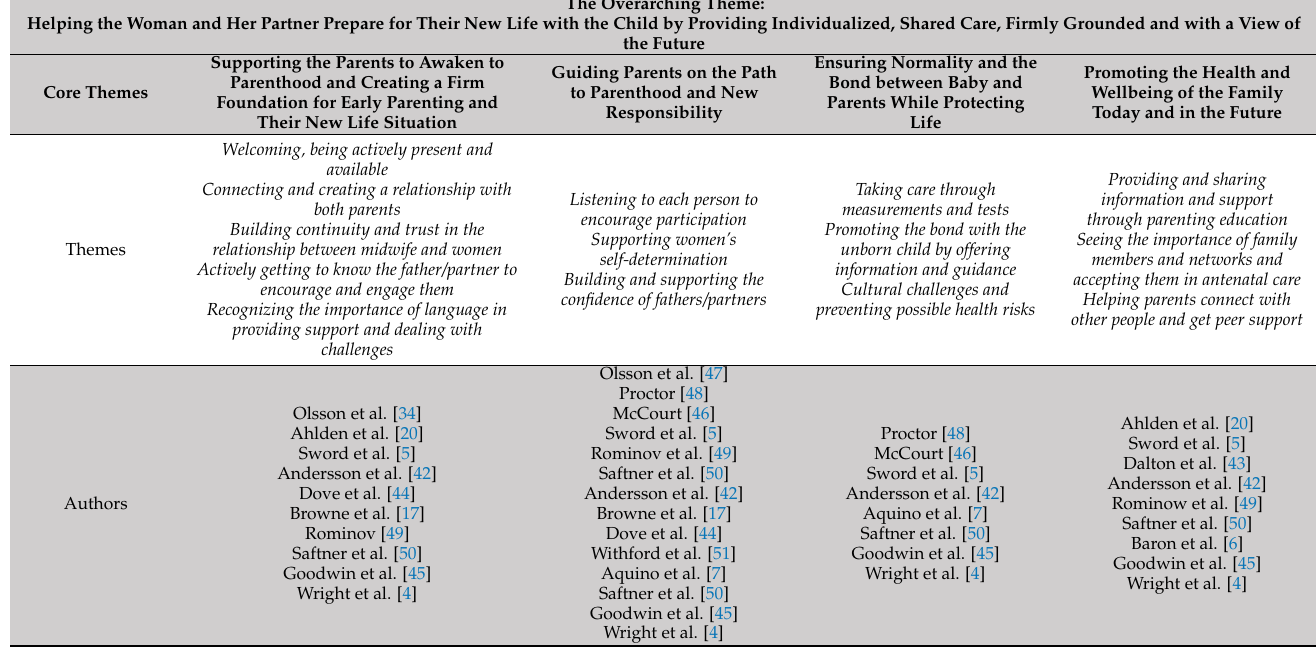
Table 5. Themes developed during the meta-ethnography to integrate